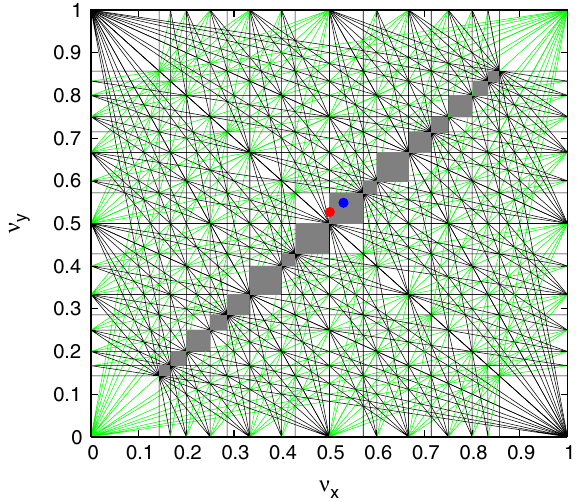
FIG. 3. A grid of sum (black) and difference (green) reso- nances up to 7th order. Shaded regions mark restricted search space for the GA, which is completely devoid of black resonance lines. The dots denote the optimal working point: red represents the betatron tunes for the proton beam, and blue for the electron